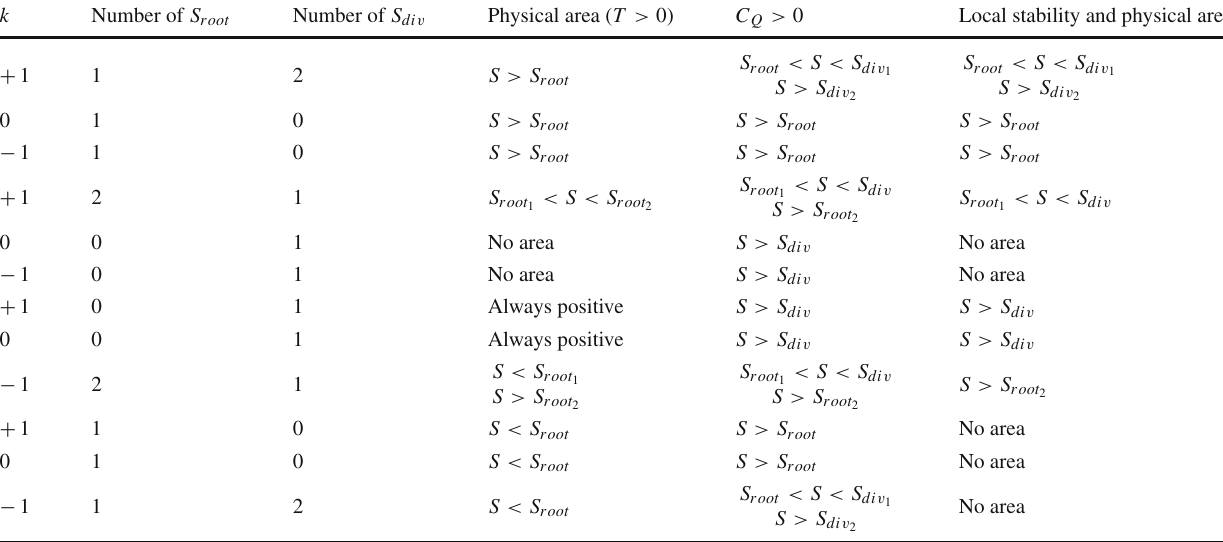
First three rows are for R 0 = 1, and η = 1. Second three rows are for R 0 = − 1, and η = 1. Third three rows are for R 0 = 1, and η = − 1. Fourth three rows are for R 0 = − 1, and η = −